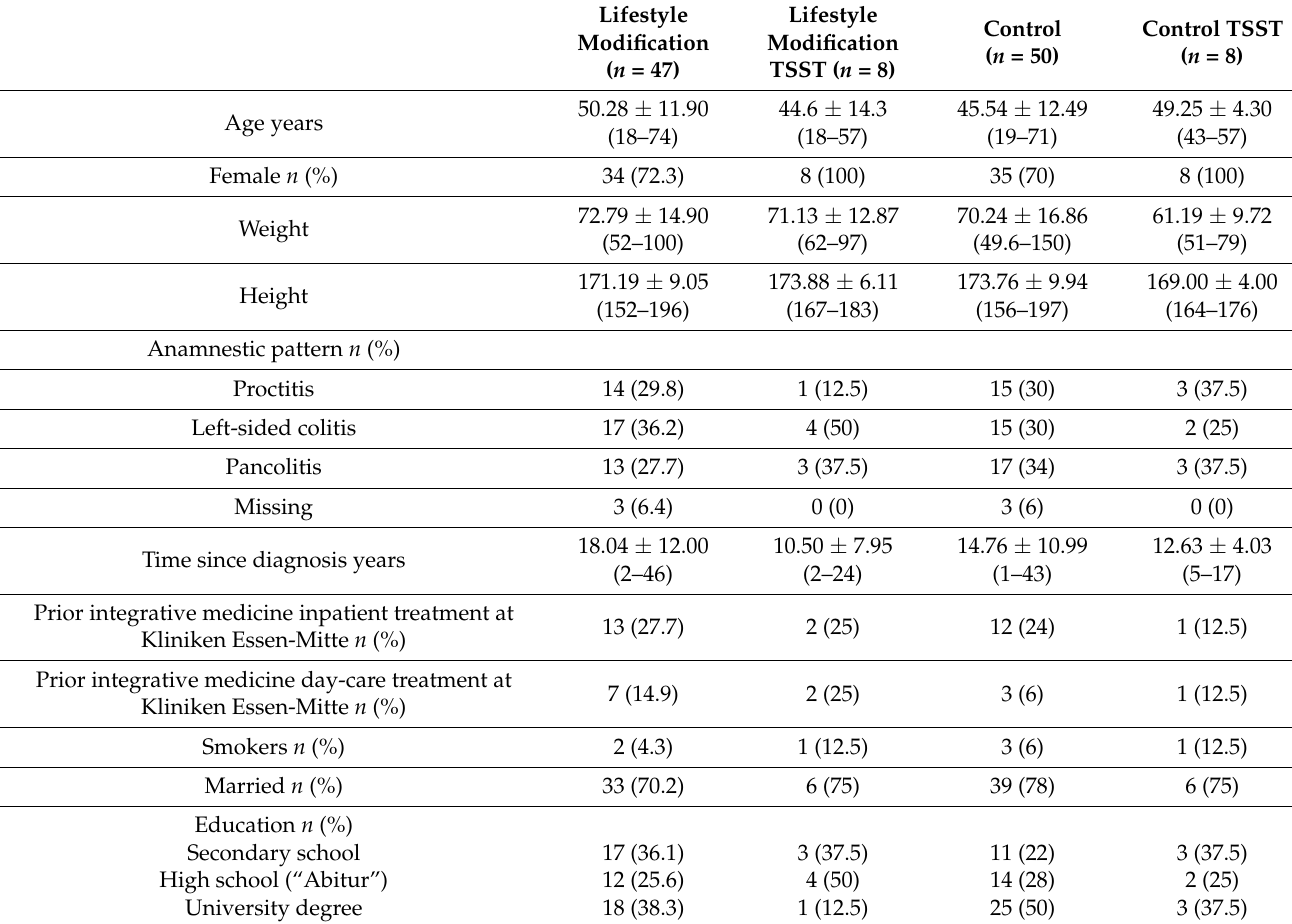
Table 1. Sociodemographic and clinical characteristics (mean ± standard deviation (range)), if not indicated